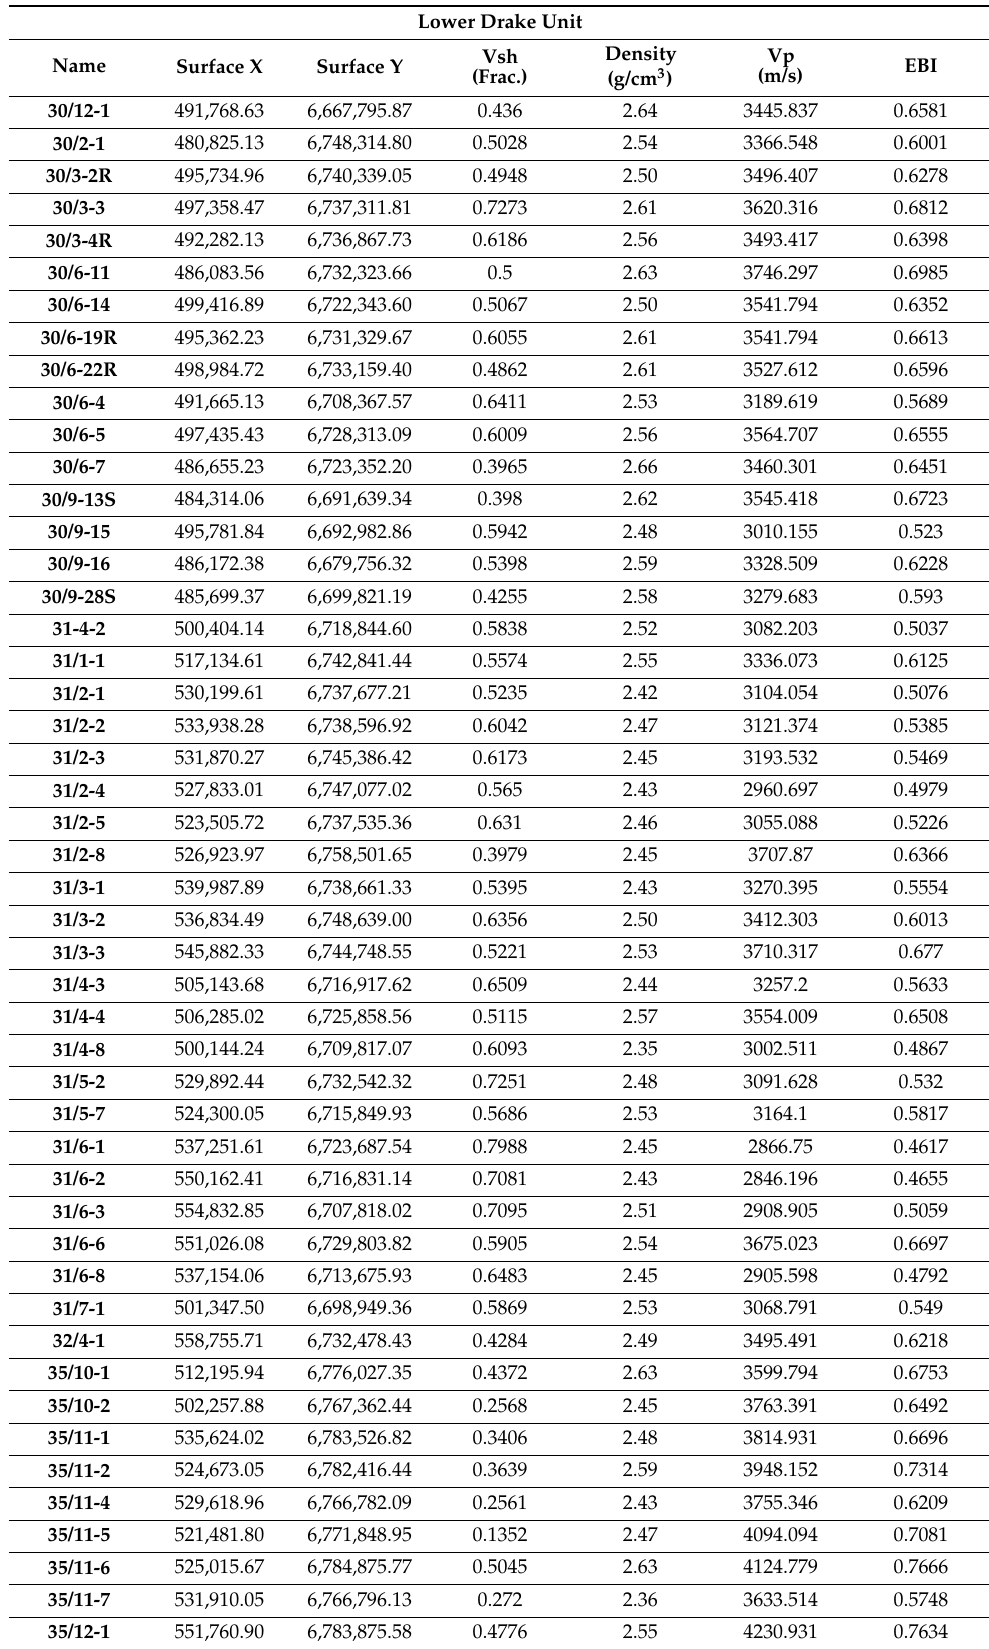
Table A2. The wells’ average properties for Lower Drake